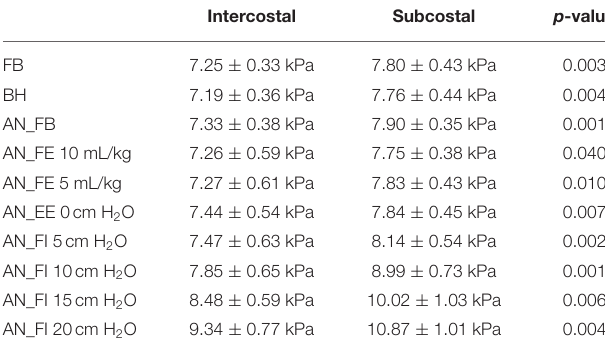
FIGURE 3 | Instrument settings for inducing forced-expiration under anesthesia during hepatic two-dimensional shear wave elastography. After connecting 50-cc syringes to the endotracheal tube with a three-way valve, the section of the tube connected to the anesthesia machine (arrow) is disconnected and blocked (open arrow) just before drawing out the air via syringes. TABLE 1 | Liver stiffness in intercostal and subcostal